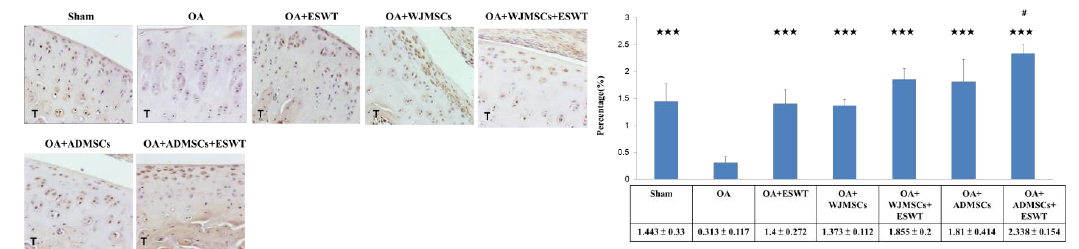
Figure 2. Treatments, histological analysis of synovium membrane, and Osteoarthritis Research Society International (OARSI) scores of the knee osteoarthritis (OA). ( A ) Sketch of the knee outlining the location of injection of WJMSCs or ADMSCs in the rats. In the left, ultrasound guidance (Toshiba Medical Systems Corporation, Tokyo, Japan) was used for localization, and WJMSCs or ADMSCs were injected into the knees of the rats. The red arrow indicates the needle of the injector. ( B ) Knee sketch outlining the locations (black dots) of shockwave application in the different groups of animals. The left picture showed that extracorporeal shockwave therapy (ESWT) was applied to the knees of the rats; n = 6. ( C ) The synovium membrane was displayed by hematoxylin and eosin staining at magnifications of 200 × . The left panel shows synovitis scores were measured in each group. ( D ) Microphotographs of cartilage and subchondral bone showed changes in cartilage damage in the OA group and protection in the treatment groups by safranin O staining. ( E ) Type II collagen ( × 200 magnification). ( F ) SOX-9 ( × 400 magnification). Scale bar represents 200 µ m; T indicates the tibia; F indicates the femur. ** p < 0.01, and *** p < 0.001 were compared with OA; # p < 0.05, ## p < 0.01, and ### p < 0.001 were compared among treatment groups. (cid:70) p < 0.05 was compared ESWT combined with ADMSCs or WJMSCs each other. n = 6 for each